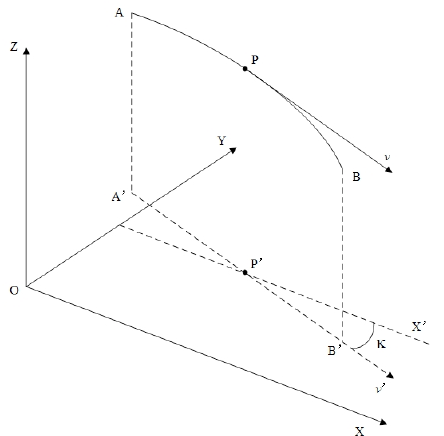
Figure 3. Diagram of the yaw angle